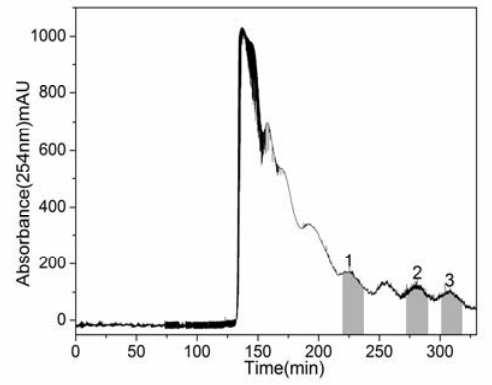
Figure 2. HSCCC separation chromatogram of n -butanol fraction of the